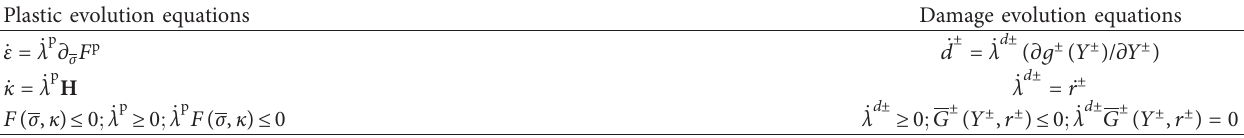
Table 6: Plastic and damage evolution equations.